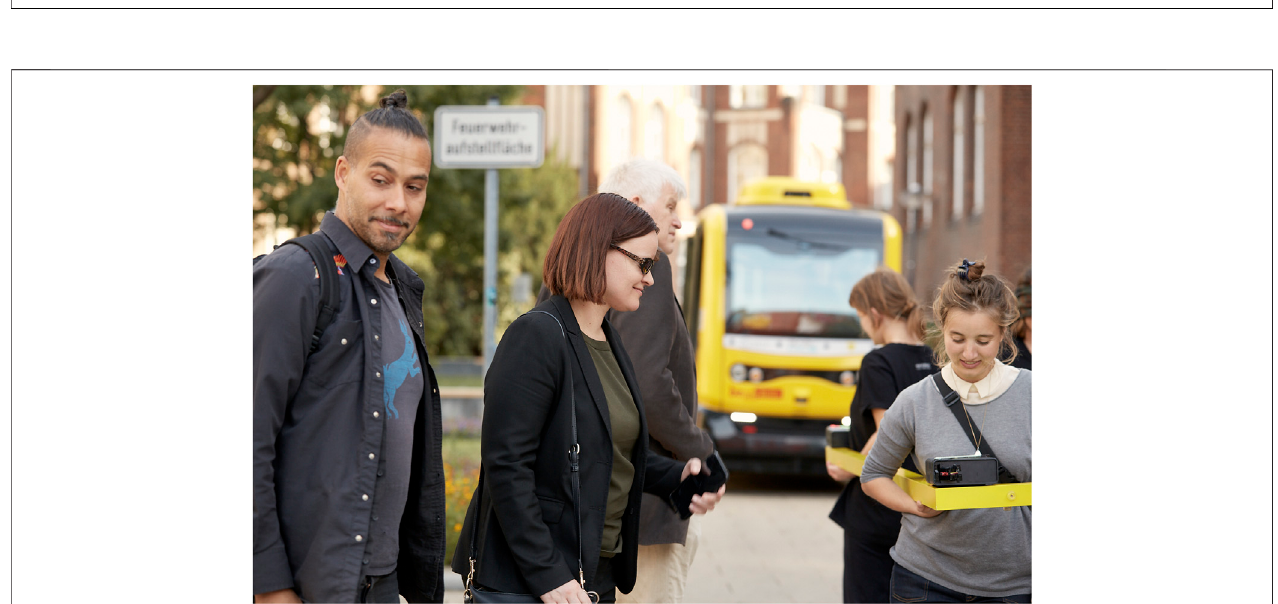
FIGURE 6 | The toy bus in the